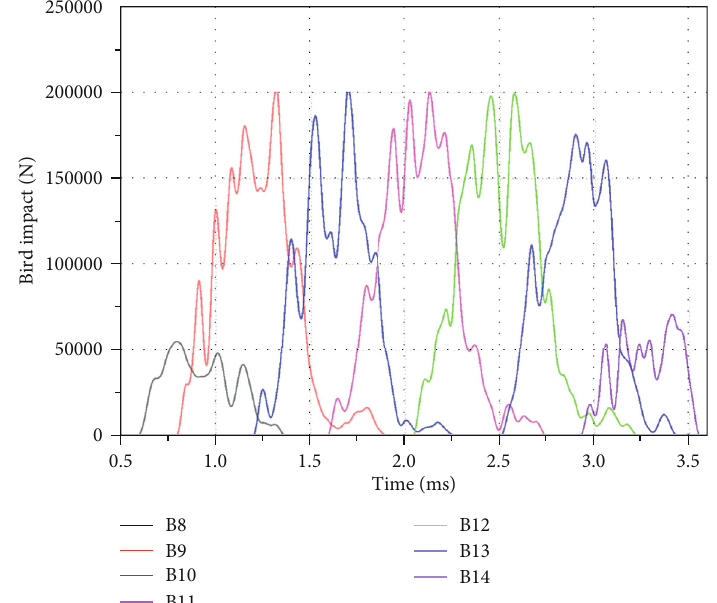
Figure 9: Bird impact force on relevant blades.